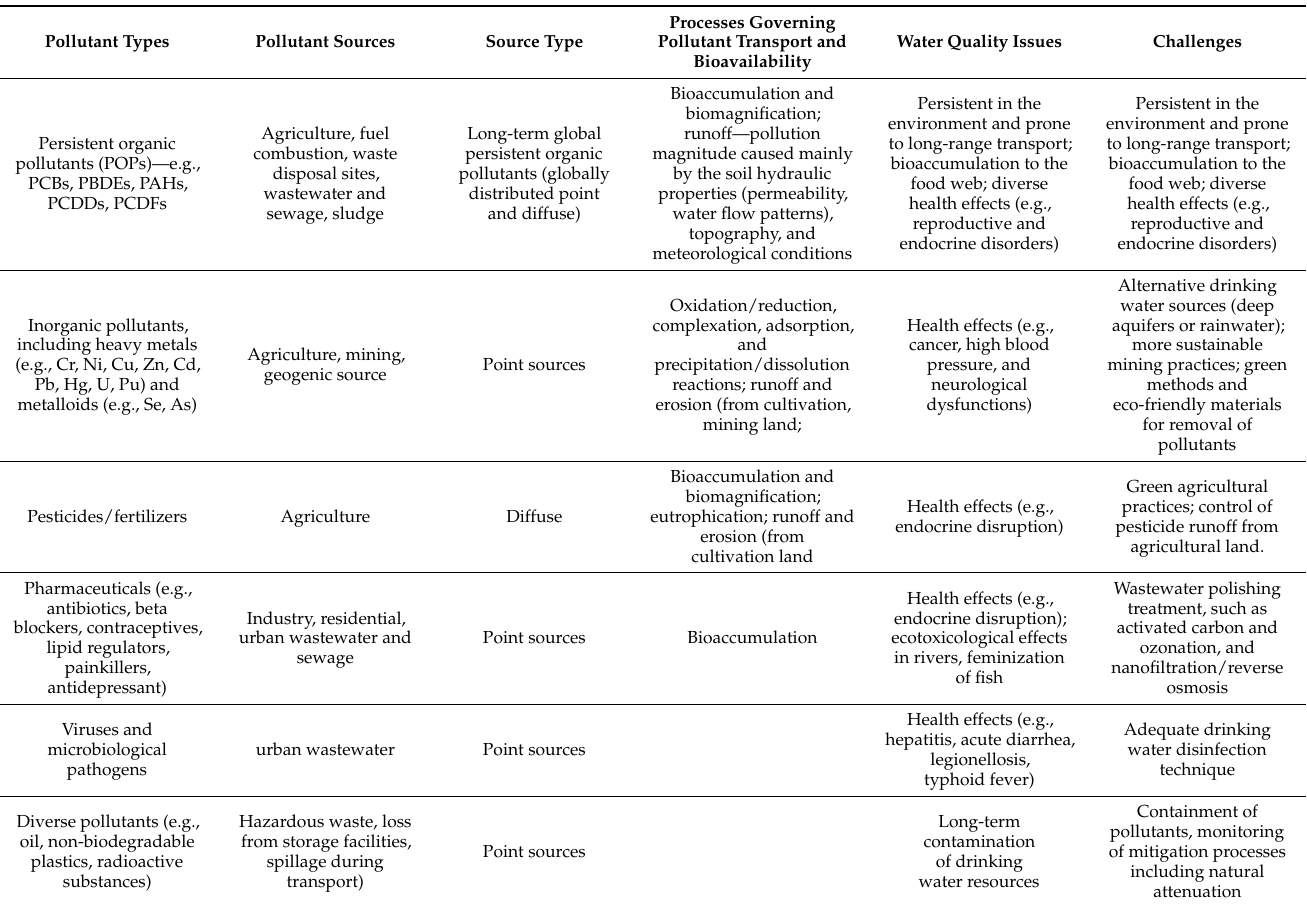
Table 1. Main water pollutants and sources